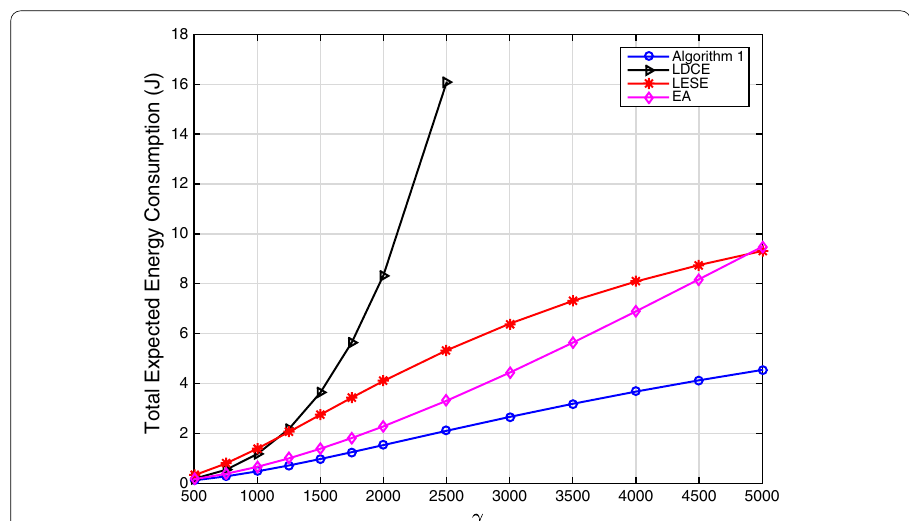
Fig. 6 Total expected energy consumption versus